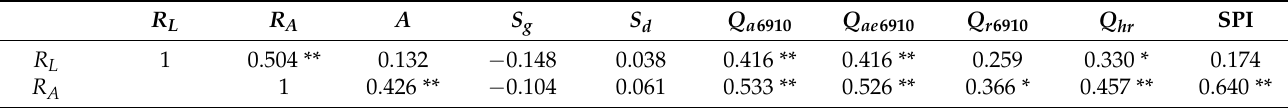
Table 4. Pearson’s correlation coefficients ( r ) of the gully growth rate and influencing factors.